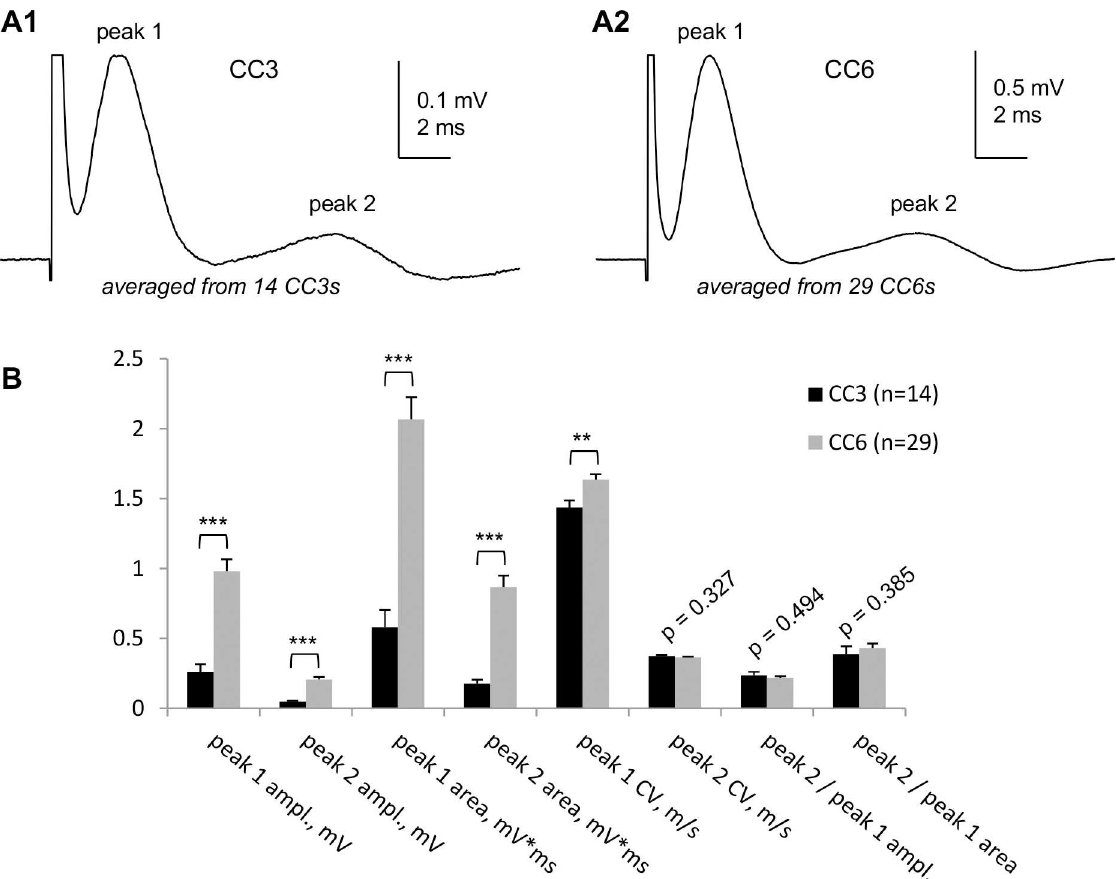
Fig 4. Detailed characteristics of “whole CC CAPs recorded at 4 mm conduction distance from CC3 and CC6. (A1, A2) Digitallyaveraged“whole”CC CAPs recordedfrom 14 CC3s (A1) and 29 CC6s (A2) from different mouse brains. The CC3 and CC6 were identifiedas explained in Fig 3. Note different voltagescales in A1 and A2. (B) Detailedstatistical comparisonof “whole” CC3 and CC6 CAP parameters: ampl.—amplitude; CV—conduction velocity; peak2/peak1 ampl.—ratio of peak amplitudes; peak2/peak1 area—ratio of peak areas. ** p < 0.01; *** p < 0.001.All recordingswere performed at room temperature.